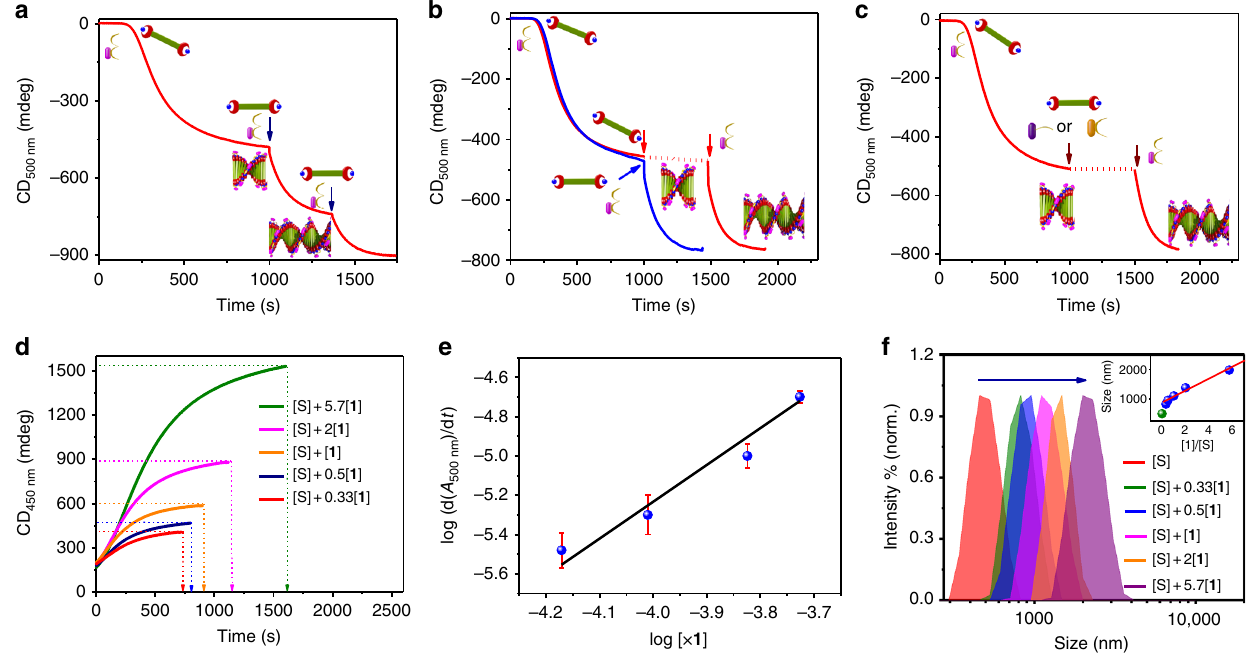
Fig. 4 ATP-selective seeded supramolecular polymerization of 1 . a CD signal showing seeded supramolecular polymerization of 1 upon two subsequent addition of monomers with ATP ( c = 2 × 10 − 5 M). b Overlaid spectra of CD changes showing the simultaneous (blue) and consecutive (red) addition of 1 and ATP to pre-grown seed. c CD signals showing no changes on addition of 5 equiv. of AMP or 2 equiv. of ADP along with 1 to a pre-grown seed, but increase in CD signal as soon as 0.9 equiv. of ATP was added to it. (Seed conc. [S] = 2 × 10 − 5 M, fresh feed conc. [ 1 ] = 1 × 10 − 5 M (5 μ L of 1 (5 × 10 − 3 M stock) and 0.45 μ L of ATP (10 − 2 M)). d CD signal showing seeded polymerization for [ 1 ]/[S] ratios of 0.33:1, 0.5:1, 1:1, 2:1, and 5.7:1. e Log – log plot of the rate of change in absorbance as a function of [ 1 ] ( x = 2, 1, 0.5, and 0.33) exhibits a linear relationship with a correlation coef fi cient of 0.98. Error bars have been shown in red for data achieved from experiments carried out for a maximum of three times. f DLS data showing the increase in hydrodynamic radii from seed (S) to varying [ 1 ]/[S] ratios (inset shows the straight line fi t of size increase for various seed concentrations where green ball is the seed size and blue balls are the sizes of seeded stacks) ([S] = 1 × 10 − 5 M, [ 1 ] = 0.33 × 10 − 5 M (1.65 μ L), 0.5 × 10 − 5 M (2.5 μ L), 1 × 10 − 5 M (5 μ L), 2 × 10 − 5 M (10 μ L), 5.7 × 10 − 5 M (2.85 μ L) (HEPES/CH 3 CN, 90/10, v/v, 0.9 equiv. ATP, 30 ATP- 1 and GTP- 1 stacks were found out to be 3.8 Å and 5.2 Å,